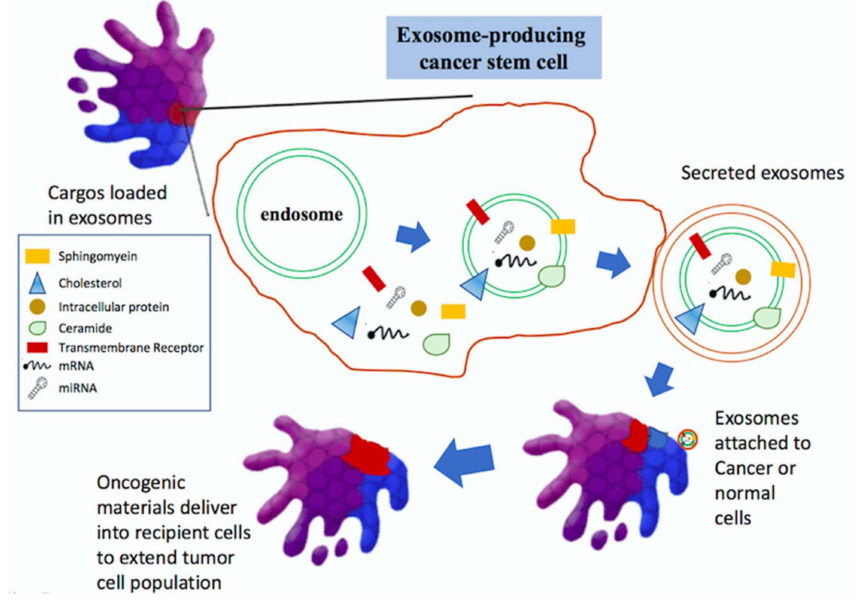
Figure 5. Roles of exosomes in